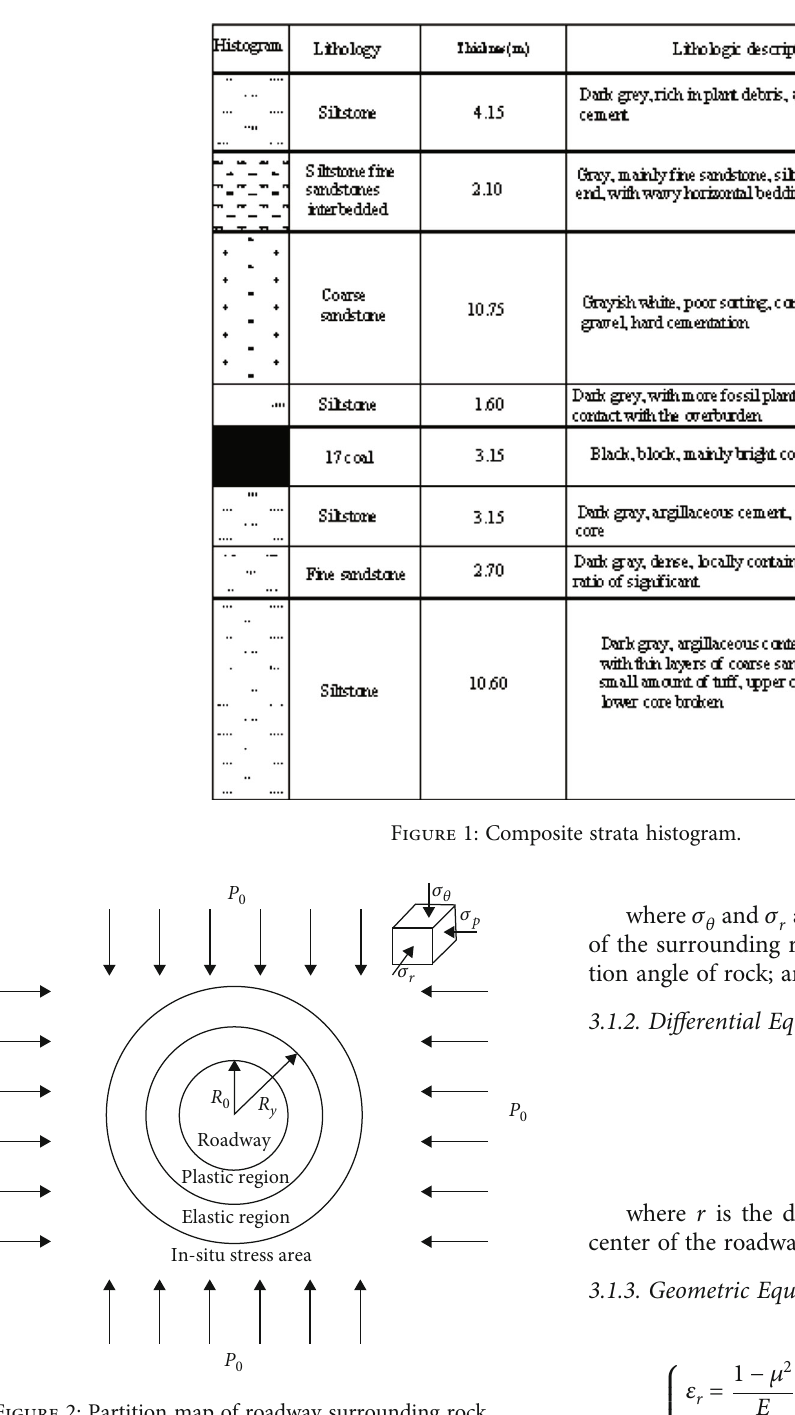
Figure 2: Partition map of roadway surrounding